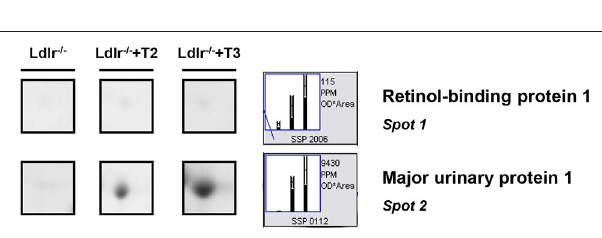
FIGURE 2 | Effects of T3 and T2 on the intrahepatic content of ApoE and ApoA1 in Ldlr − / − mice. Representative subsections of 2D-E images of livers of Ldlr − / − , Ldlr − / − + T2, and Ldlr − / − + T3 mice are reported. Results are expressed as arbitrary units (means ± SD; n = 4).